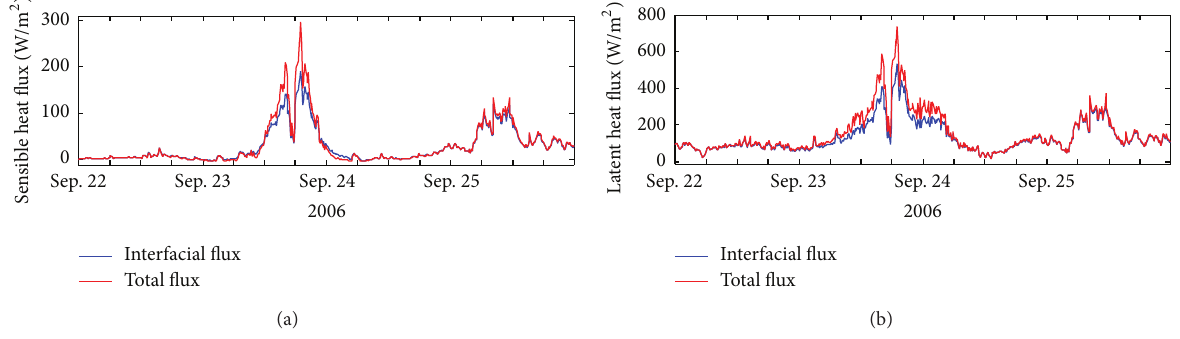
Figure 4: Time series of (a) sensible heat flux and (b) latent heat flux at the KEO station where the simulated typhoon passed by at 18:00 September 23. Blue line and red line represent interfacial heat flux and total heat flux, respectively.